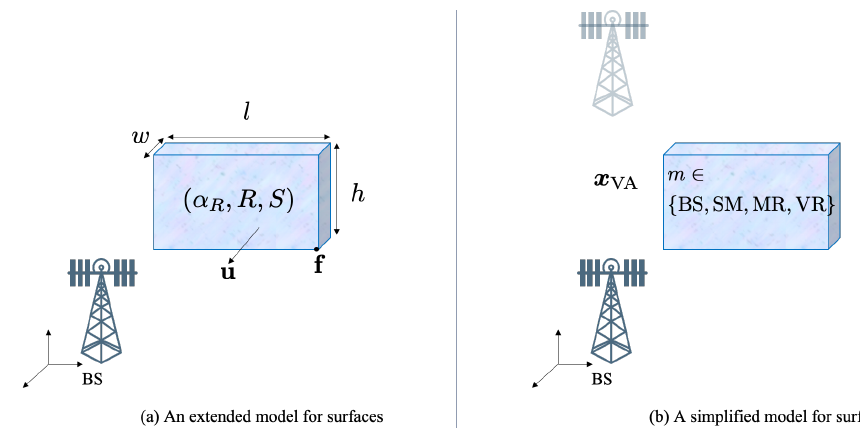
Figure 2. Two different surface models: ( a ) shows a high-dimensional model, while ( b ) is a compact model that expresses the location of the surface via a virtual